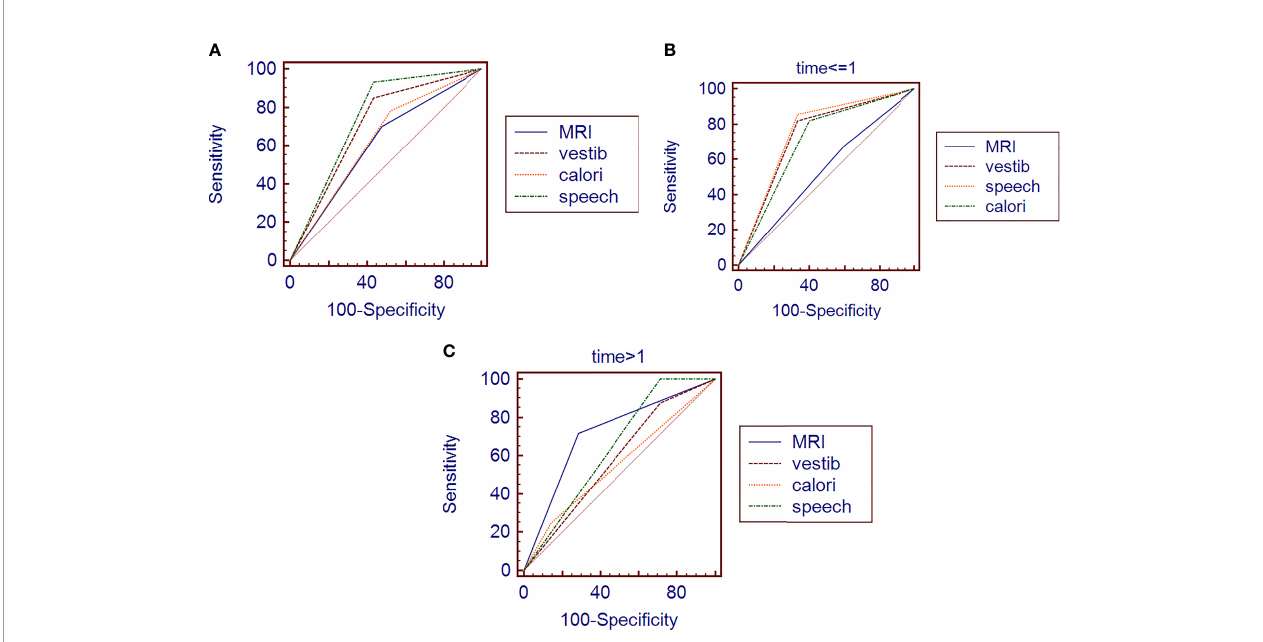
FIGURE 1 | ROC of different variables in general (A) /in early-stage group (B) /in late-stage group (C) . MRI, MRI result before surgery; vestib, vestibular function impairment before surgery; calori, caloric test before surgery; speech, audiometry before surgery time, the course of disease (we divided the patients into early-stage and late-stage groups by the course time of one